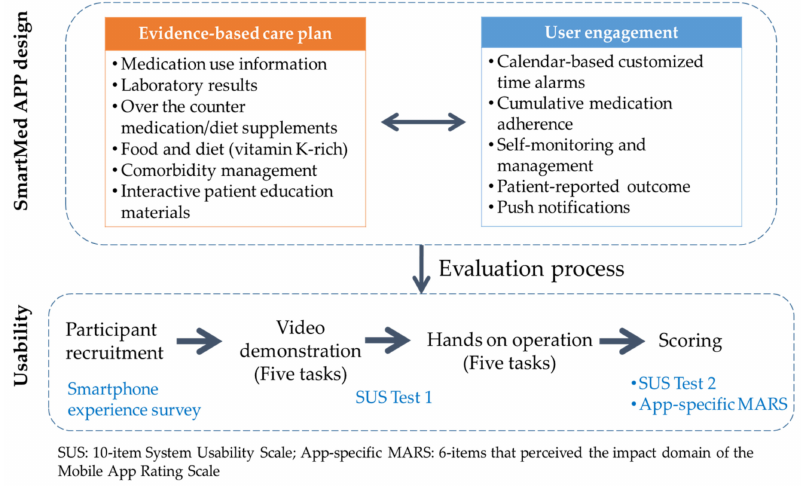
Figure 1. Study design and evaluation process.